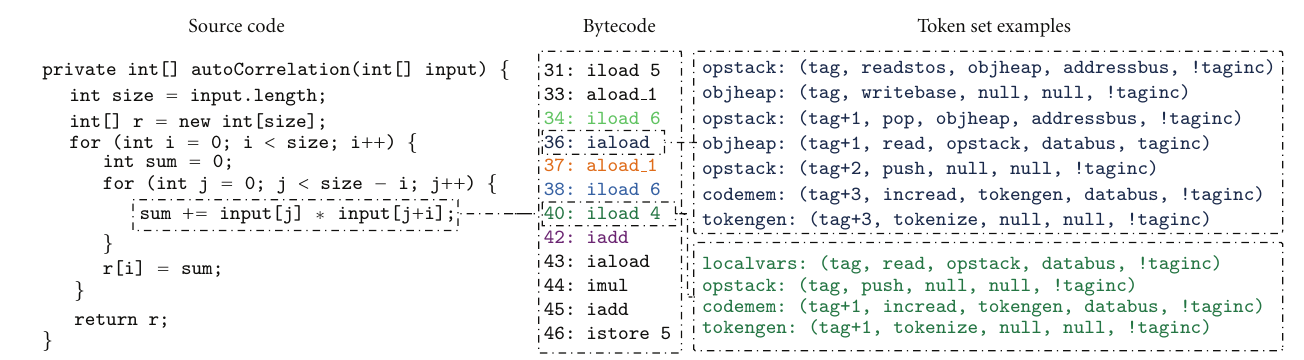
Figure 3: Example source code sequence and the resulting bytecode and exemplified token